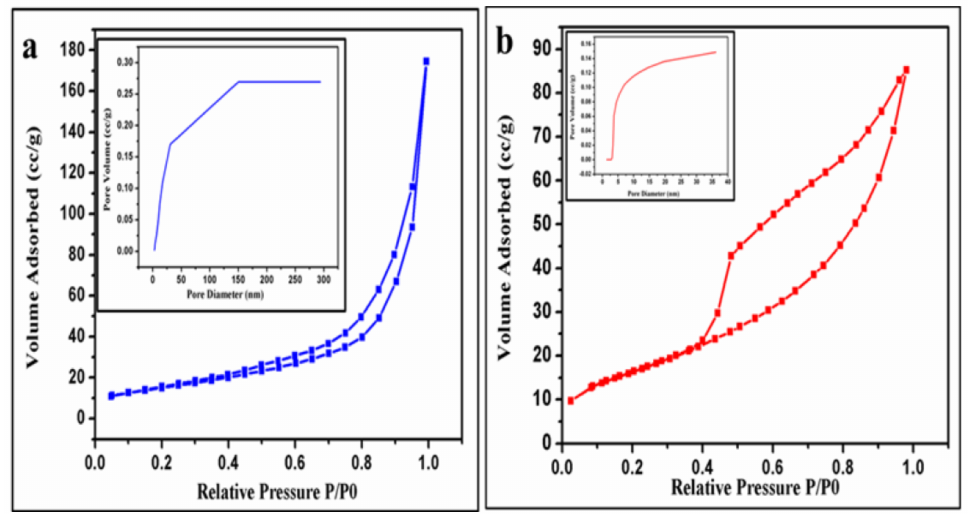
Figure 11. N 2 adsorption–desorption BET isotherm and the pore size distribution (inset) for Halloysite clay ( a ) and HC/ZnONC ( b